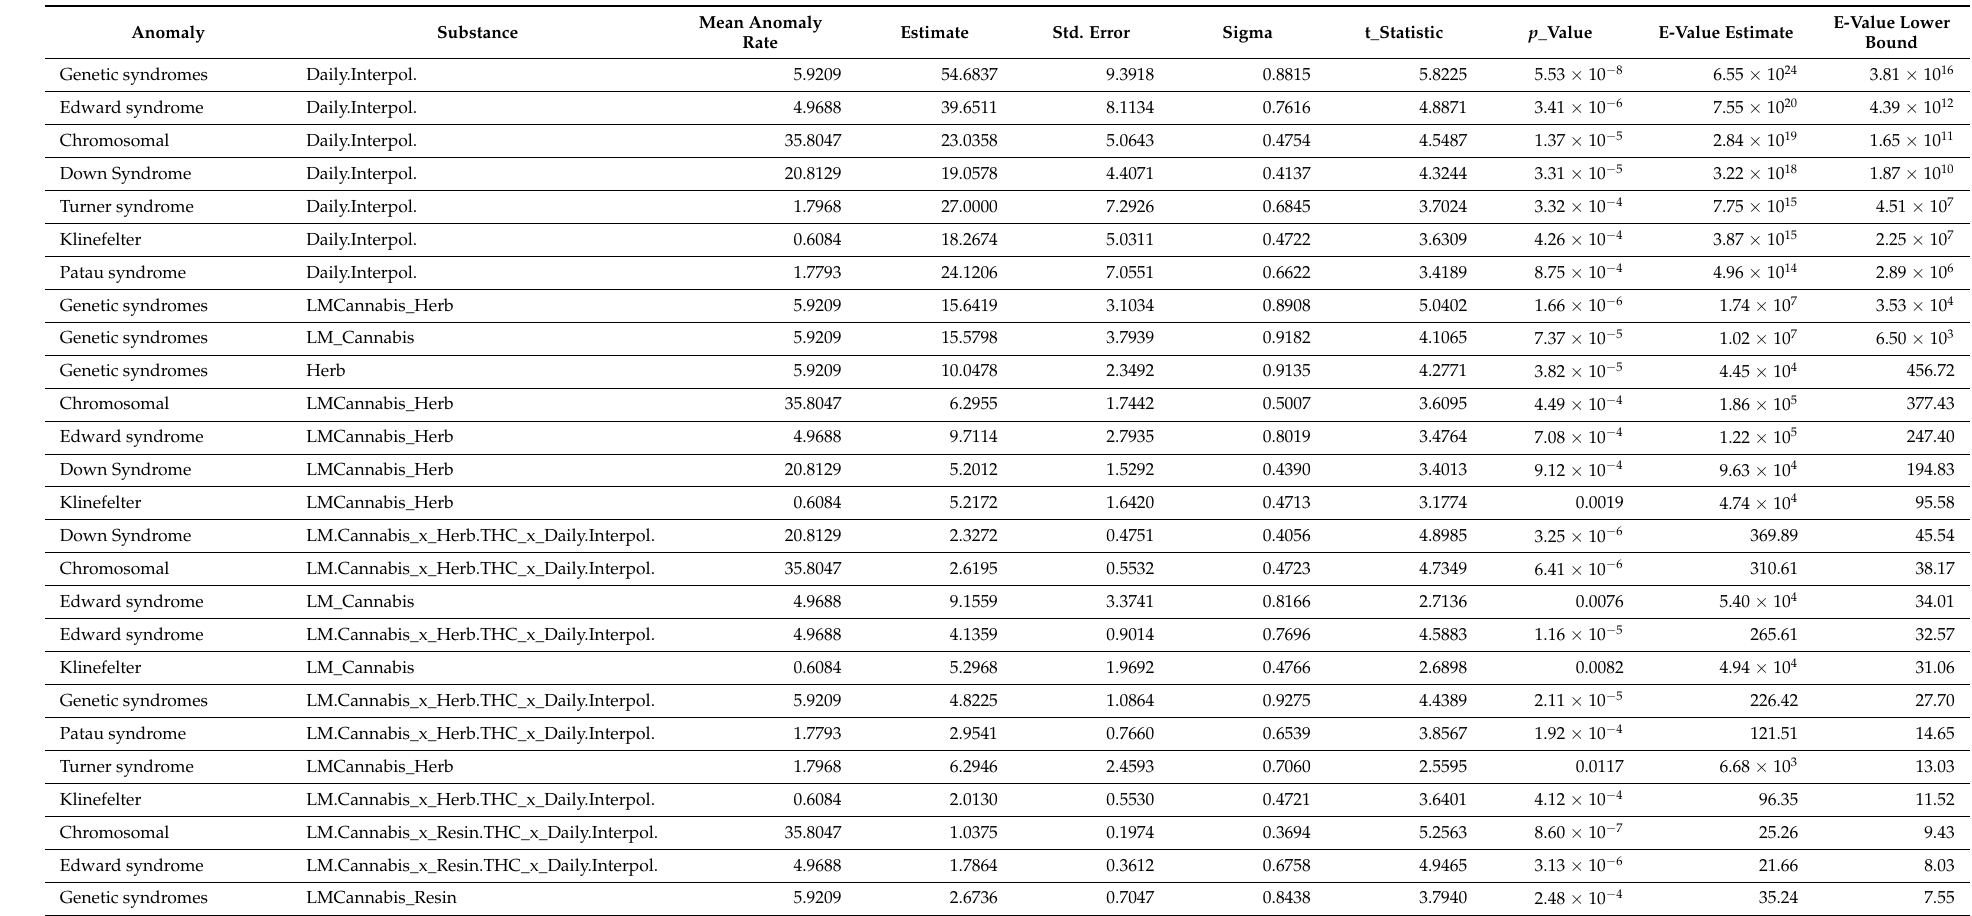
Table 1. Positive and Significant Slopes from Bivariate Linear